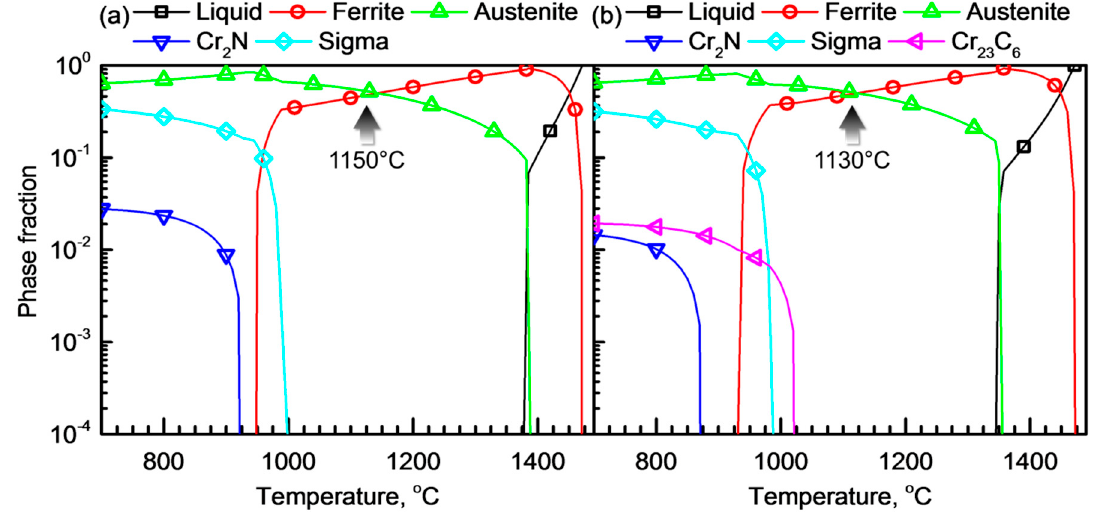
Figure 1. Equilibrium phase fractions of the ( a ) duplex stainless steel containing N only (DSS-N) and ( b ) duplex stainless steel containing N and C (DSS-NC) as functions of temperature, calculated using Thermo-Calc software (version 2017b, database TCFE 7.0).